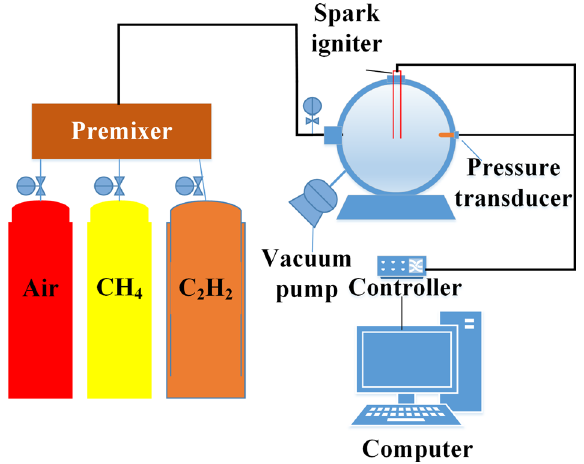
Figure 1. Experimental